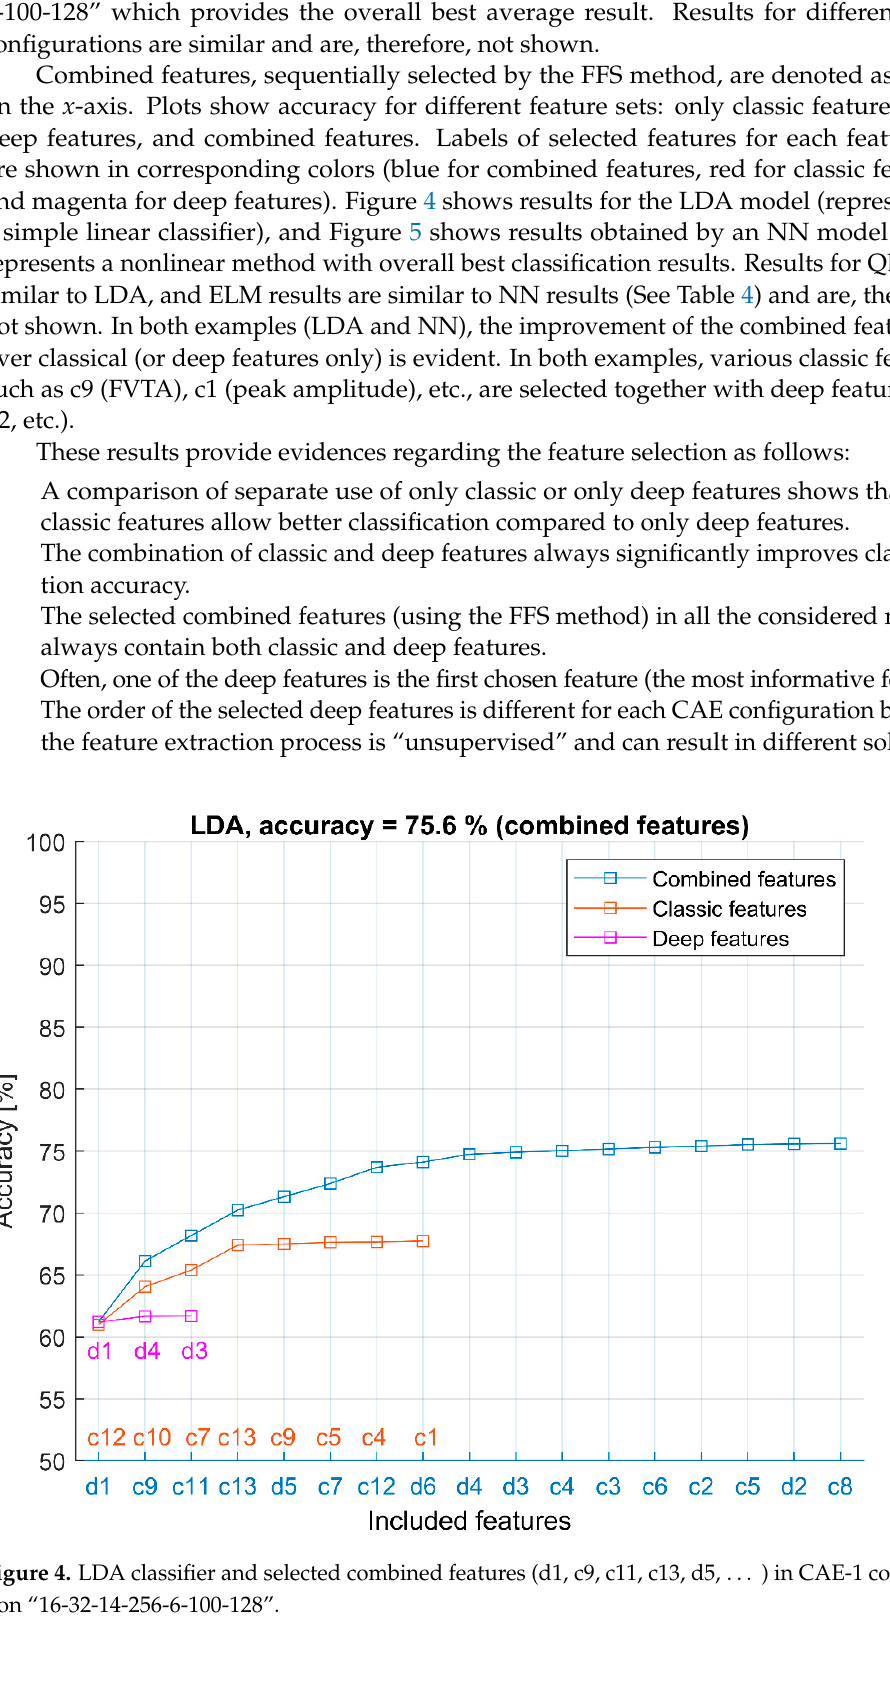
Figure 5. NN classifier and selected combined features (c1, d1, c11, d5, c3, …) in CAE-1 configura- tion “16-32-14-256-6-100-128”. These results provide evidences regarding the feature selection as follows: